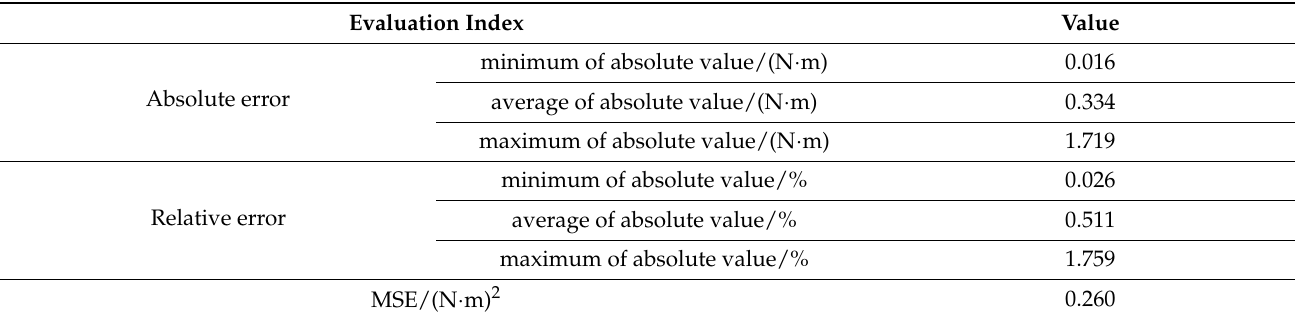
Table 2. Test set prediction results.